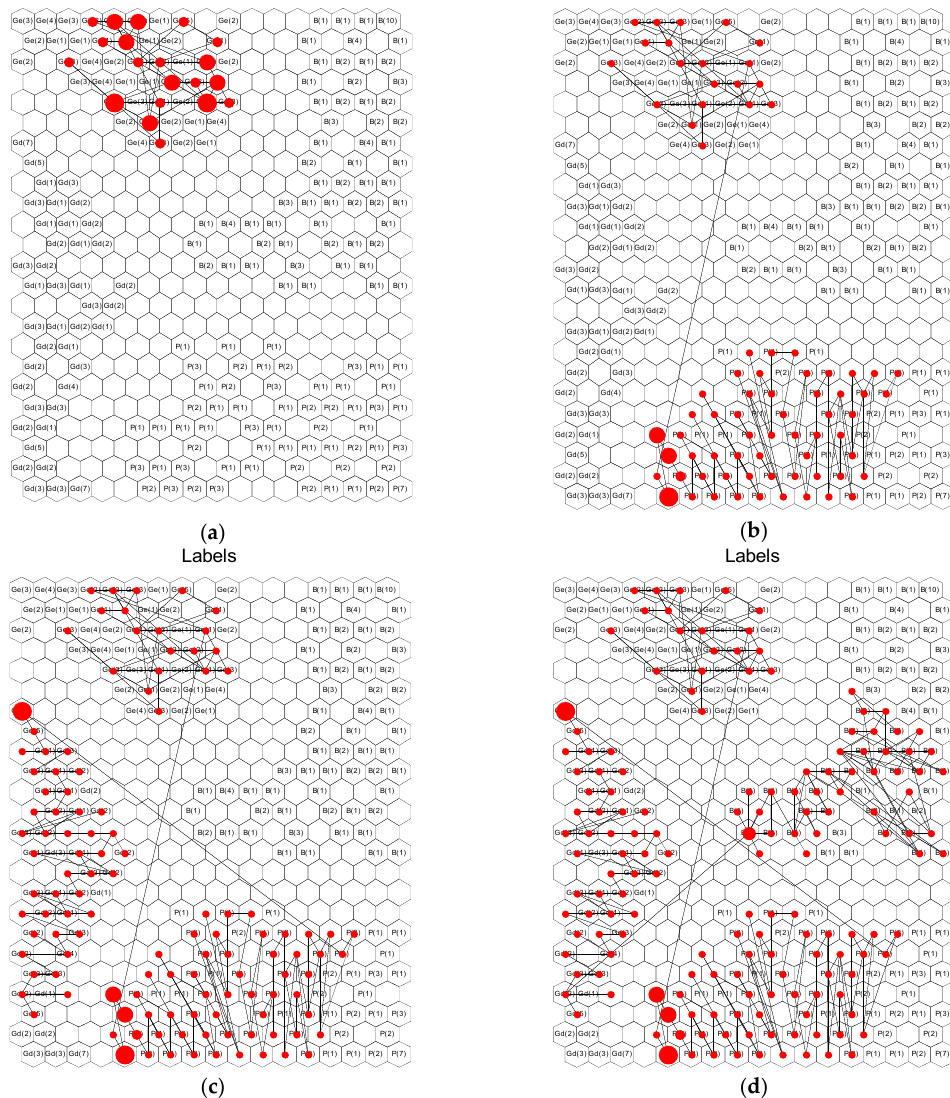
Figure 8. Online process operation performance monitoring results. ( a ) general; ( b ) general–poor; ( c ) general–poor–good; ( d ) general–poor–good–best.